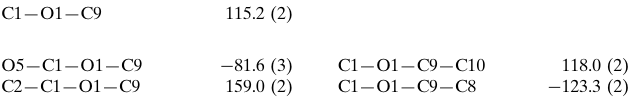
Selected bond and torsion angles ( (cid:4) ).